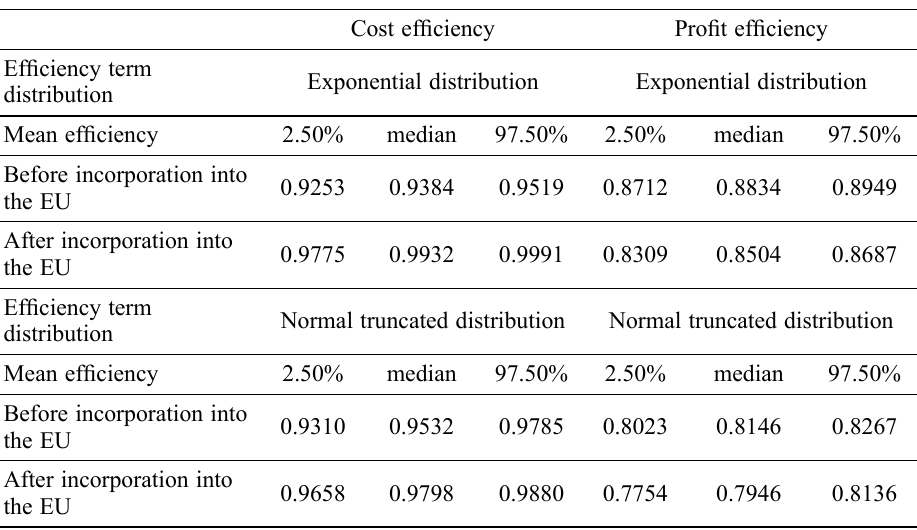
Table 4. Estimated mean bank efficiency before and after the incorporation of the bank’s country into the EU